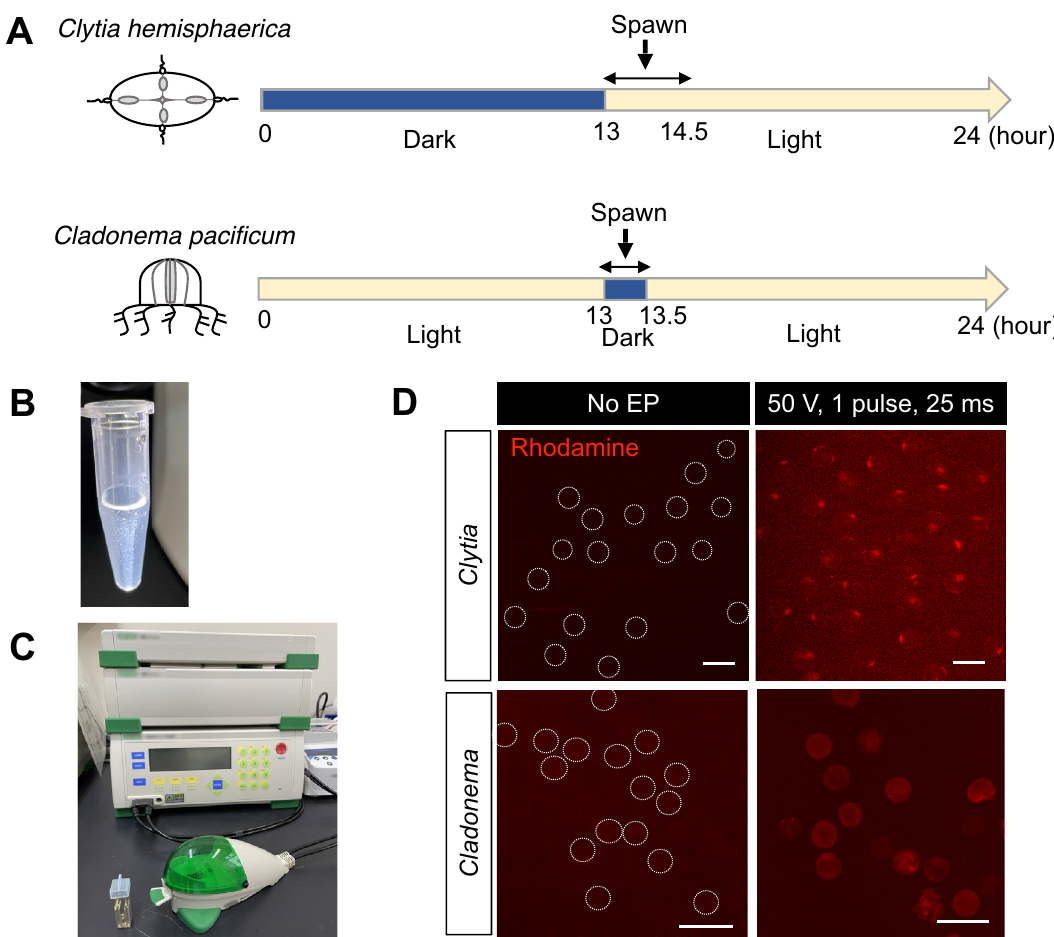
Figure 2. The electroporation procedure for jellyfish eggs. ( A ) Schematic of spawning under the 24 h light/dark cycle. Clytia hemisphaerica are maintained on a 13 h dark/11 h light cycle. After light stimuli, sperm spawning occurs within 60–90 min and egg spawning occurs within 90–120 min. Cladonema pacificum are maintained on a 23.5 h light/0.5 h dark cycle. After dark stimuli, sperm and egg spawning occurs within 25 min. ( B ) Fertilized eggs are resuspended in 15% Ficoll/artificial sea water to prevent precipitation of eggs during electroporation. ( C ) Electroporation is performed with the Bio-Rad Gene Pulser Xcell electroporation system and a cuvette with a 4 mm gap. ( D ) Visualization of the Rhodamine-Dextran delivery into eggs by electroporation. Rhodamine is shown in red. While little or no fluorescence was observed in eggs without electroporation (No EP), under the condition of a single 50 V pulse for 25 ms, rhodamine signals were detected in both Clytia and Cladonema eggs without cell damage. For clarity, egg outlines are indicated with dashed lines for eggs without electroporation. Scale bars: 200